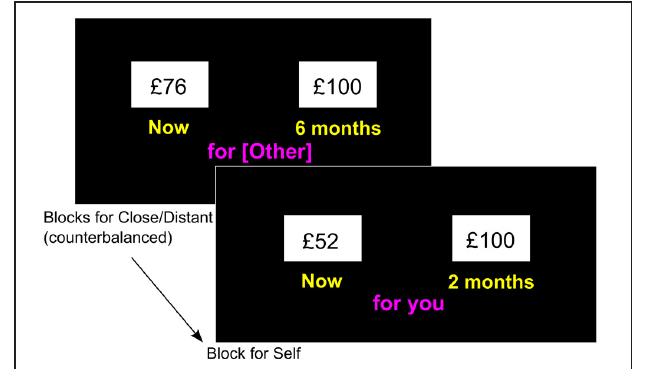
FIGURE 2 | Task design and an example trial from each social condition block (note: delay, immediate amount and sides on which amounts are presented vary within blocks).